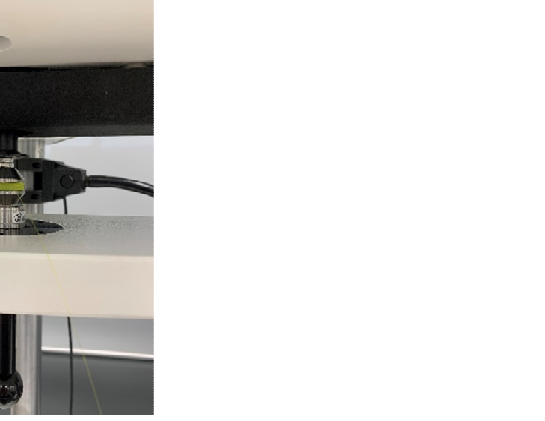
Figure 2. Compression test of the FBG secured on the PDMS gel membrane using a mechanical tester.